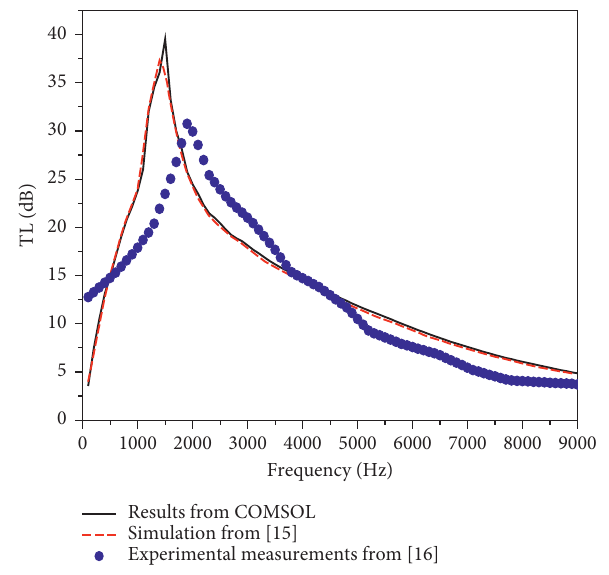
Figure 2: Validation of the simulation calculation from COMSOL.